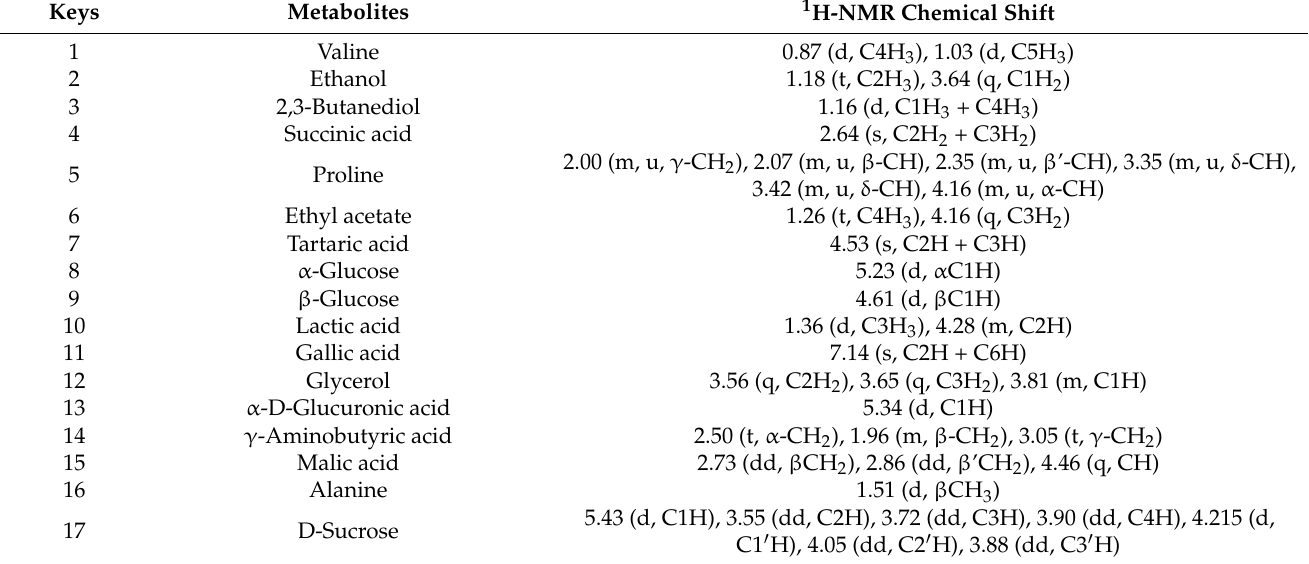
Figure 6. 1 H-NMR spectra of wine metabolites from Helan Mountain in Ningxia. Table 1. 1 H-NMR assignment of metabolites in